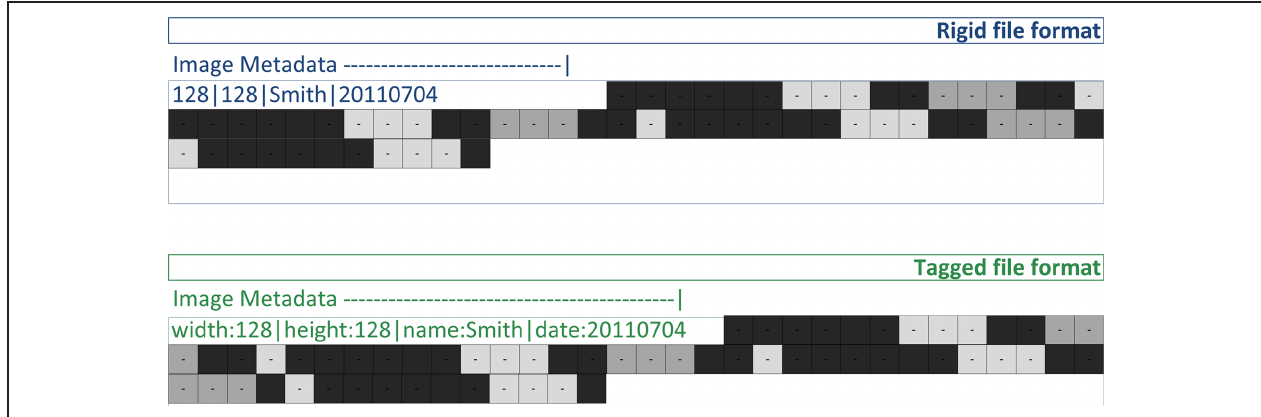
FIGURE 2 | Image files contain both image metadata and pixel values (shown as gray squares). A rigid file format defines locations in the file for the image metadata values (128, 128, “John”). A tagged file format stores image metadata as name/value pairs (e.g., “name” associated with